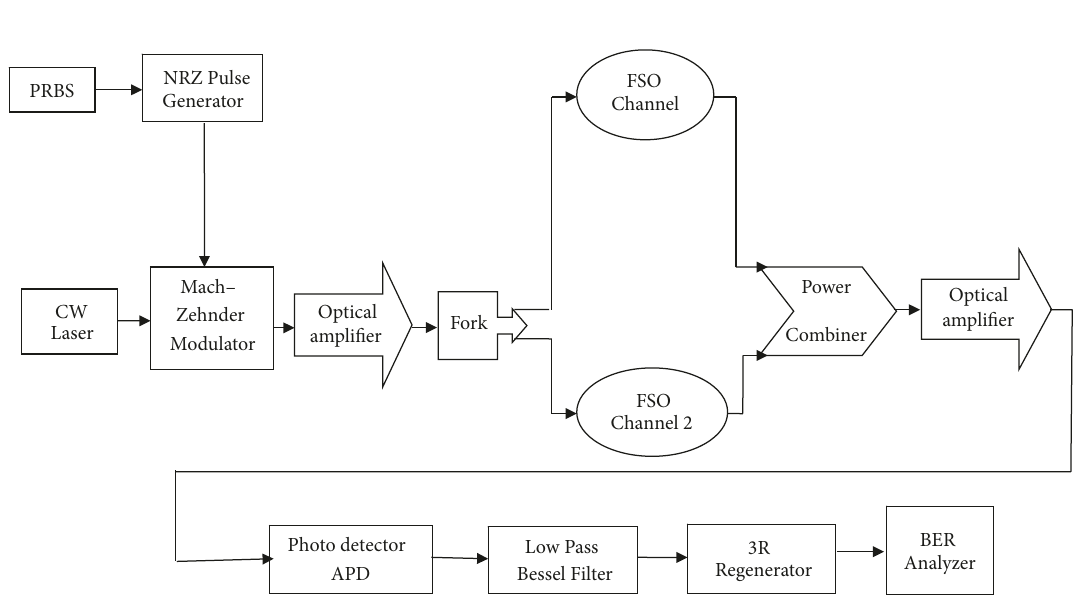
Figure 3: Simulation layout of (2 T X /2 R X ) FSO